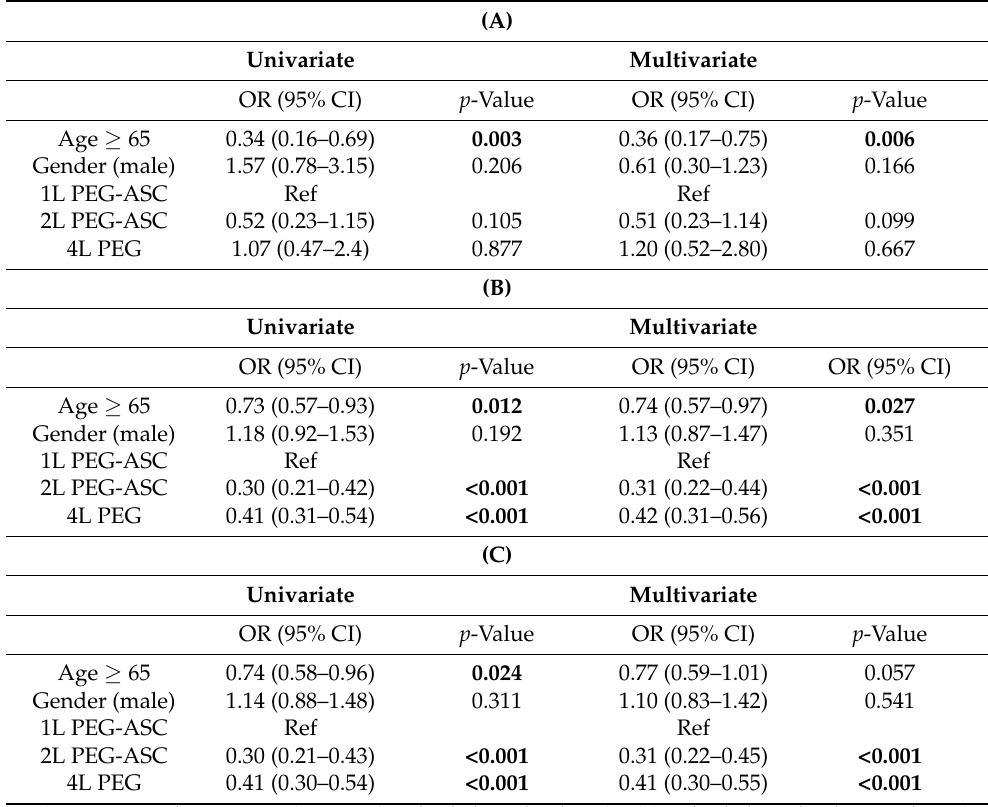
Table 2. ( A ) Predictors for adequate bowel cleansing (BBPS total score ≥ 6). ( B ) Predictors for high-quality bowel cleansing (BBPS total score = 9. ( C ) Predictors for high-quality cleansing of the right colon (BBPS Right colon =